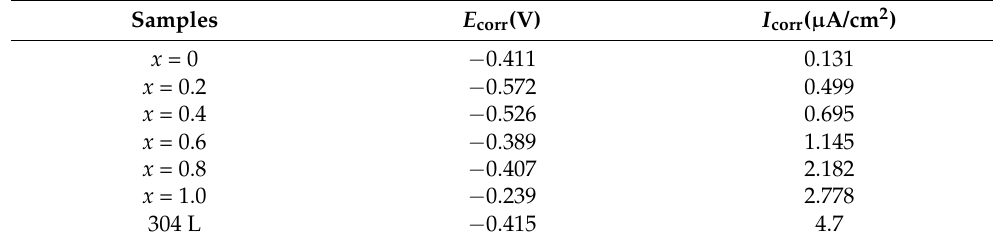
Figure 5. Potentiodynamic polarization curves of AlCrTiV 0.5 Cu x lightweight HEAs in 0.6 M NaCl solution. Table 1. Electrochemical corrosion parameters of AlCrTiV 0.5 Cu x lightweight HEAs obtained from potentiodynamic polarization curve measured in 0.6 M NaCl solution.